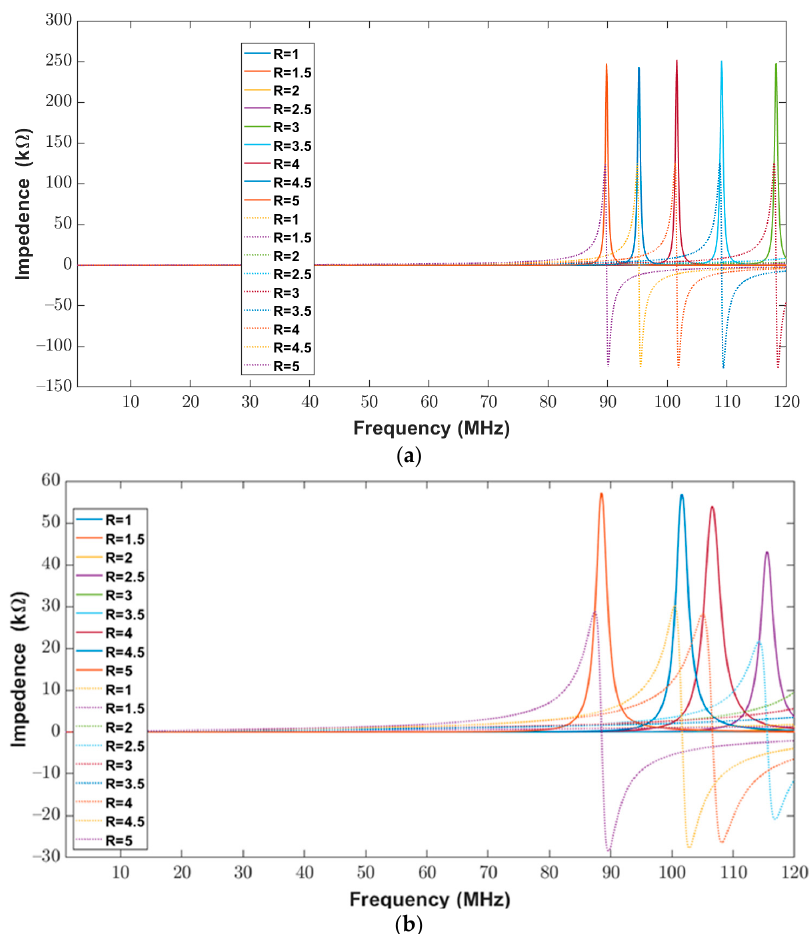
Figure 13. Impedance (Real (solid lines) and Imaginary (dotted lines) components) of elliptical planar inductors for the full range of frequencies from 20 Hz to 120 MHz with varying major-to-minor ratios while trace separation ( S ) and trace width ( W ) were kept constant to 200 μ m ( a ) Computed response using proposed model ( b ) Measured response from the impedance analyzer. 3.3. Estimation Results for Varying Ratios of Inner Minor Diameter to the Inner Major Diameter between 1 to 5 While Keeping Trace Separation and Width Fixed at 300 μ m To validate the impact of varying trace width and separation for varying major-to- minor ratios of one to five, the trace width and separation were set to 300 μ m while the number of turns was kept fixed at 10. The inner minor diameter was set to 10 mm, while the inner major diameter was varied from 10 to 50 mm to achieve major-to-minor ratio values of between one and five. The calculated and measured inductance values are listed in Table 10. To compute the difference between the calculated and measured inductance values, the absolute percentage error has been calculated and is tabulated in Table 10.